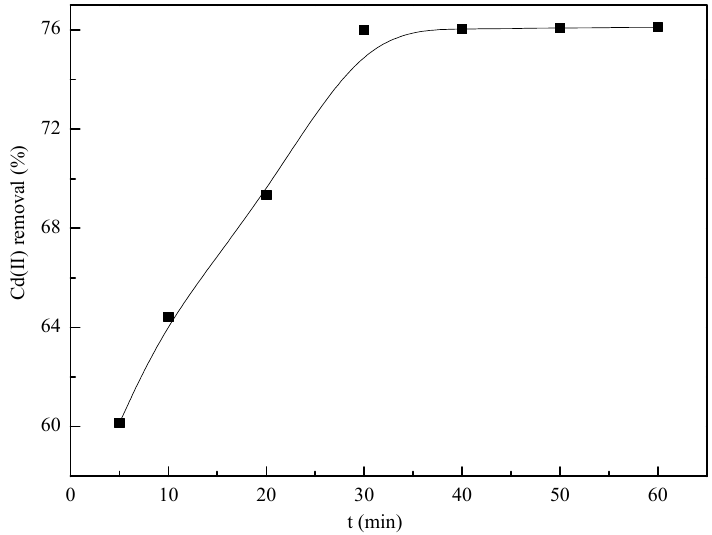
Figure 9. Cd(II) removal kinetics of the nZVI/rGO composites (initial pH = 7.0; nZVI/rGO composites dosage = 30 mg; operating temperature = 20 °C; Cd(II) concentration = 20 mg/L).